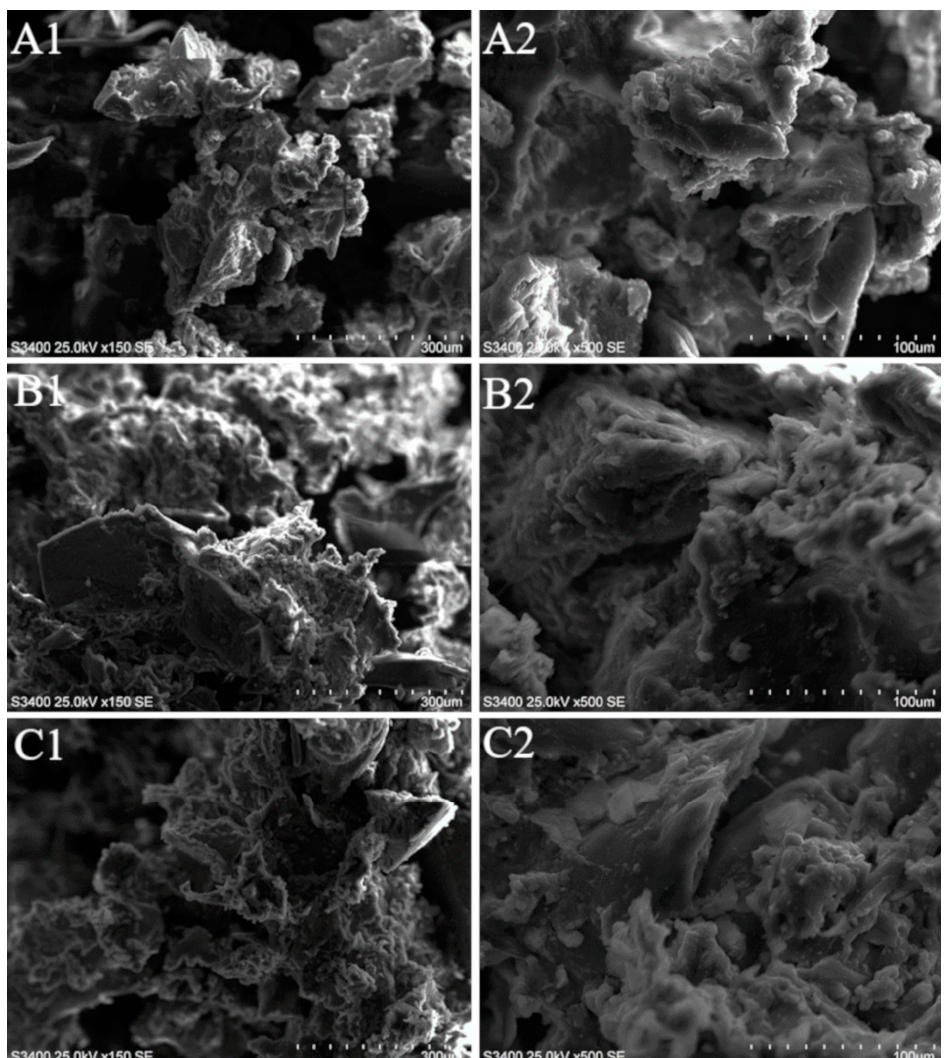
Figure 6. SEM images of: GTR ( A 1—magnification ×150, A 2—magnification ×500), GTR-EXT ( B 1—magnification ×150, B 2—magnification ×500), GTR-AUTO-EXT ( C 1—magnification ×150, C 2—magnification ×500).